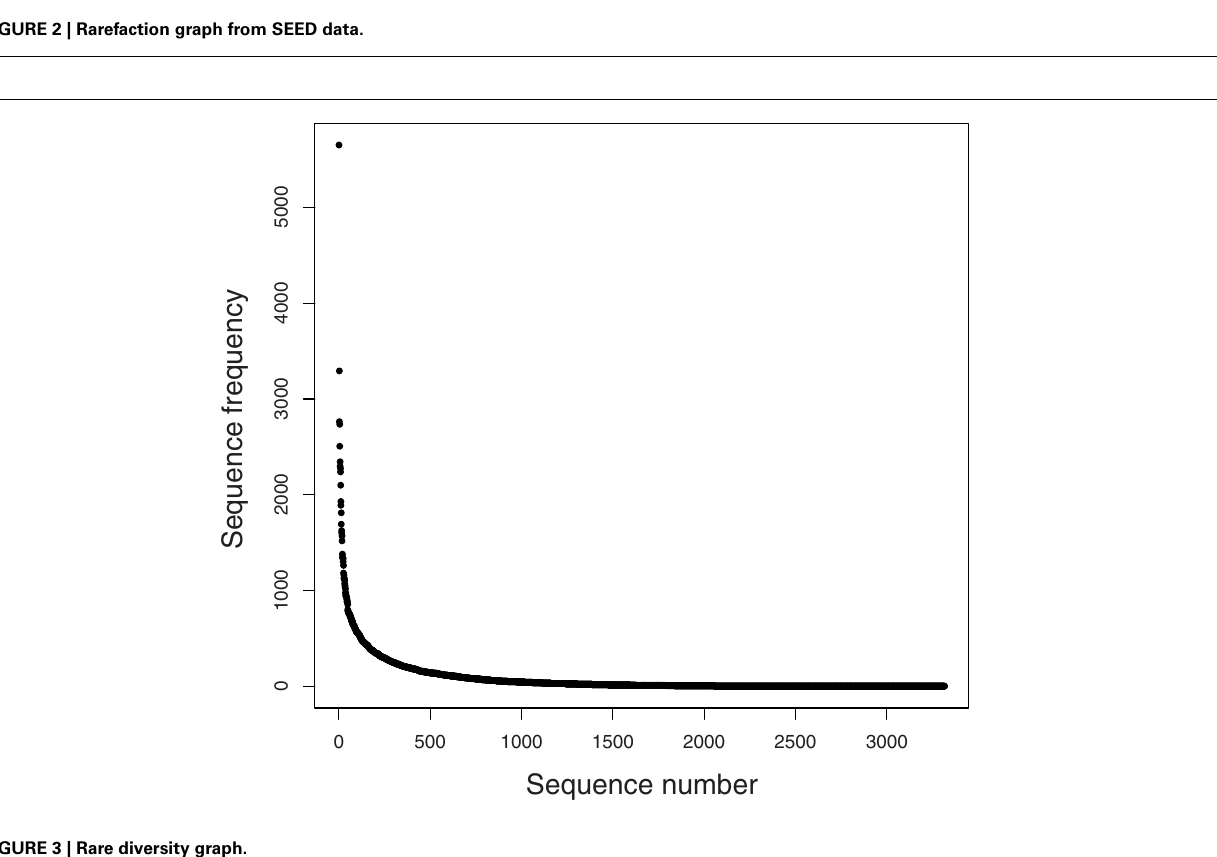
FIGURE 3 | Rare diversity